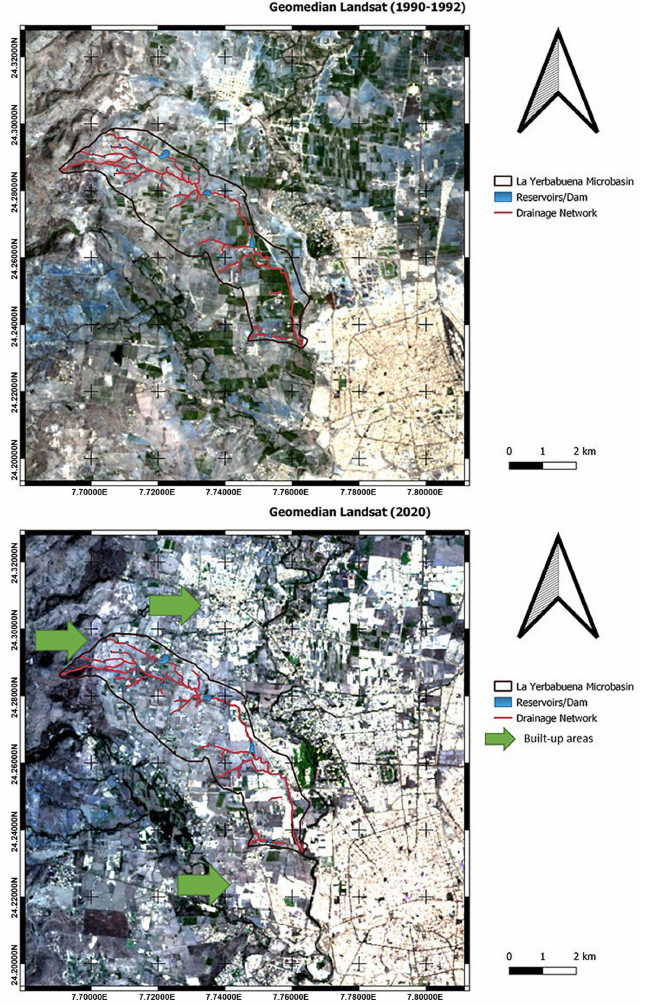
Figure 5. Geo-median Landsat image: it includes the development of urbanization in the study area, from the first image (1990–1992) to the one in the lower part, which is the most recent condition